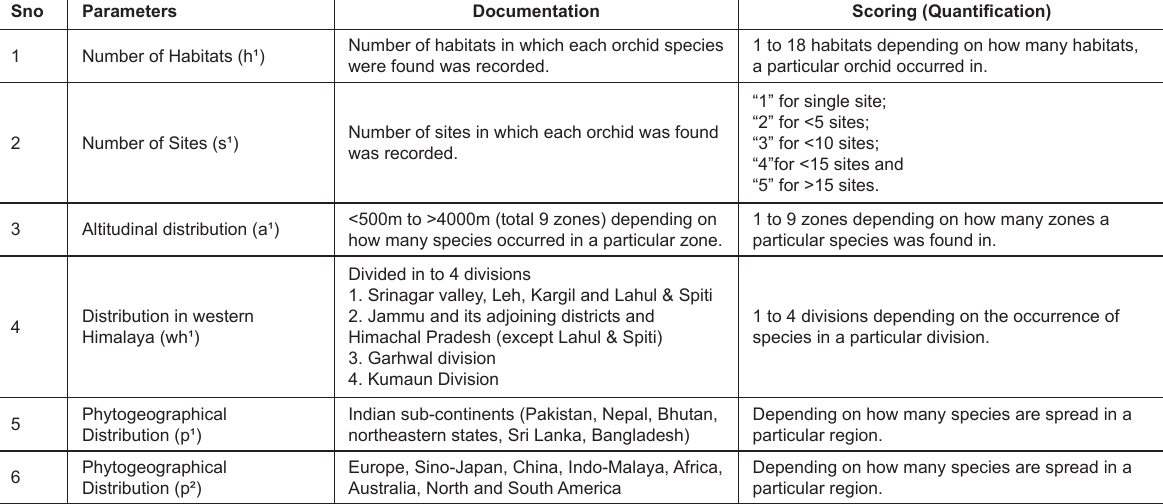
Table 2. Quantification parameters of rarity for each orchid